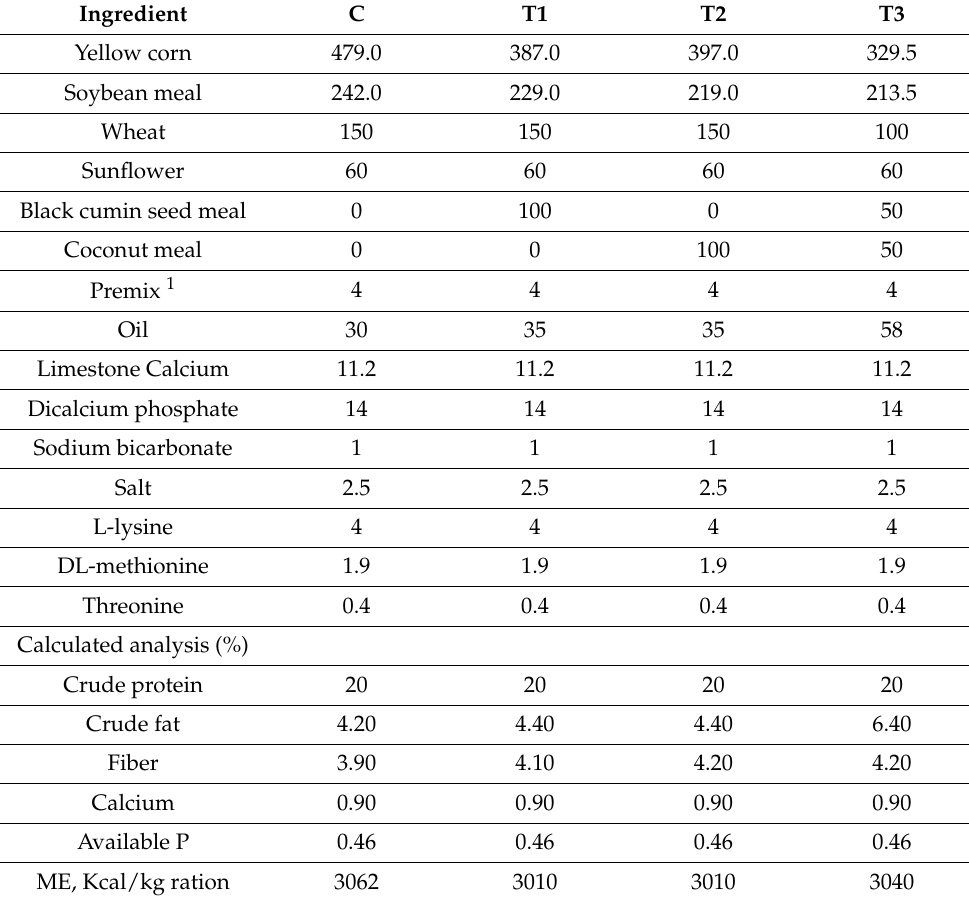
Table 2. Composition of the grower diets fed to broilers in four feeding trials, g/kg. Ingredient C T1 Yellow corn Soybean